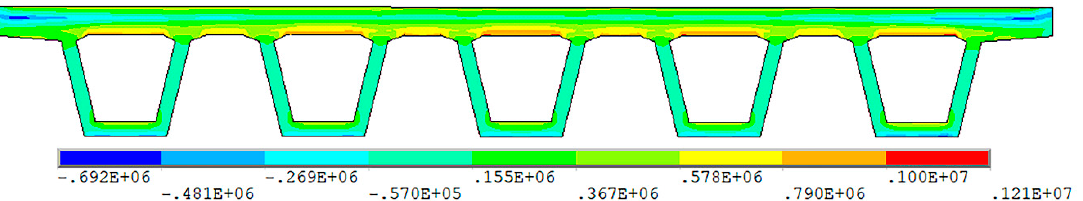
Figure 13. Transverse normal stress distribution under maximum positive lateral temperature gradient (unit: Pa).